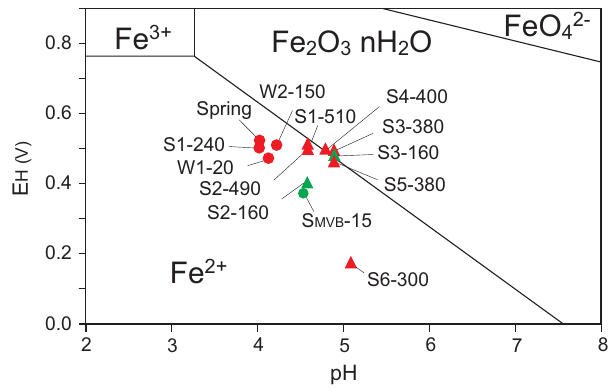
Fig. 8. Position of the groundwaters in the iron Pourbaix diagram drawn for low Fe-concentrated waters ( < 10 6 M). Symbols are the same as in Fig.